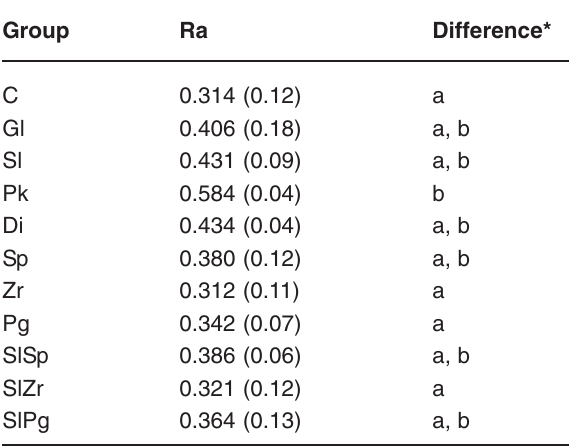
Table 5- Mean (SD) of surface roughness and differences between groups for Mark II porcelain